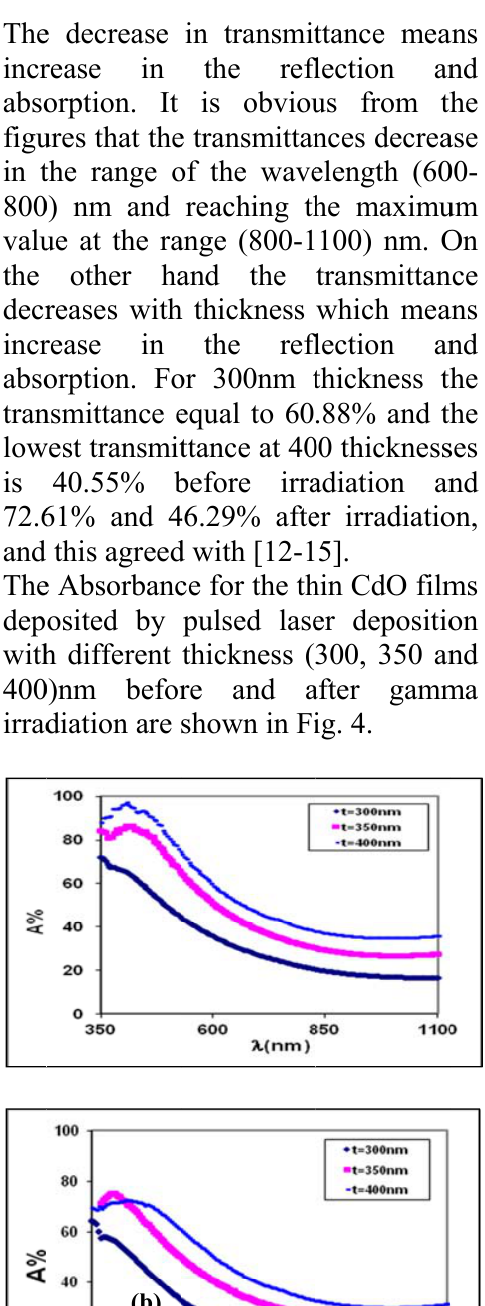
eflectance of hickness (300